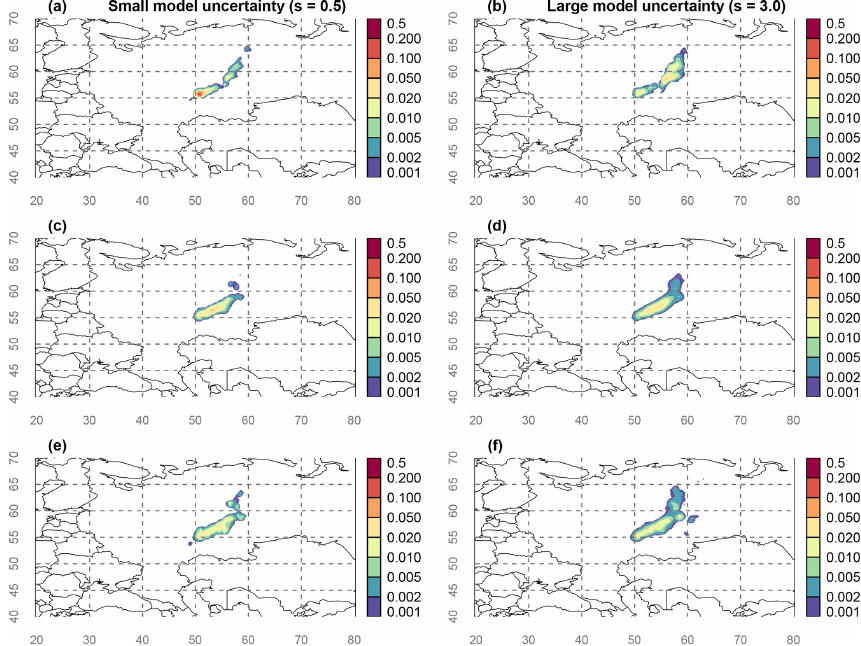
Figure 8. Source location probability maps for (a) , (b) the unperturbed member; (c) , (d) the grid-box-wise ensemble mean; and (e) , (f) the grid-box-wise ensemble maximum. Panels (a) , (c) , and (e) were obtained using s = 0 . 5; panels (b) , (d) , and (f) were obtained using s = 3 . 0. The longitude and latitude are shown by grey numbers and dashed